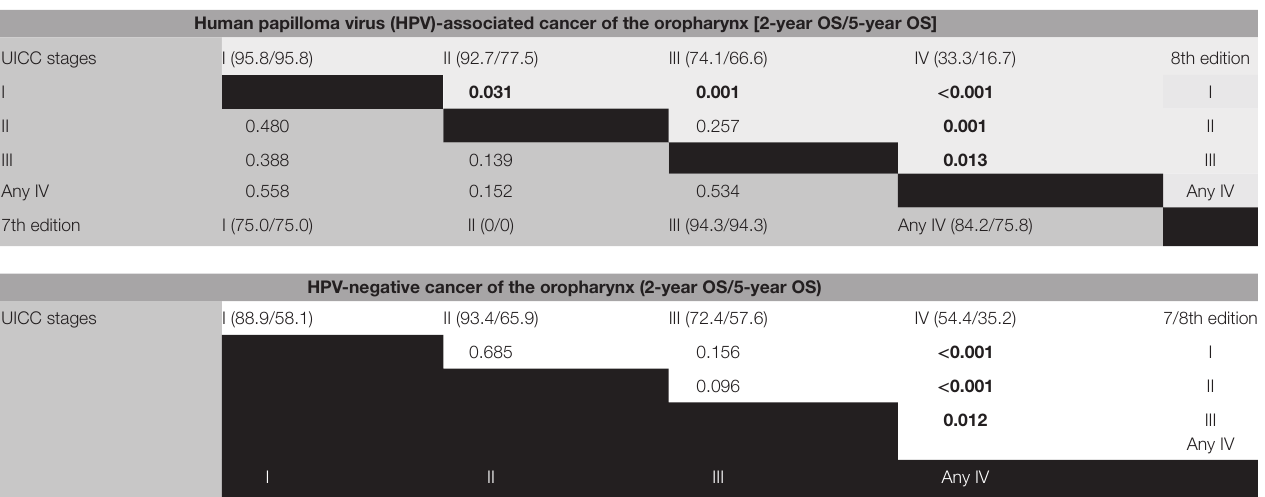
taBLe 6 | Survival differences and discriminative power of stage groupings in oropharyngeal cancer.